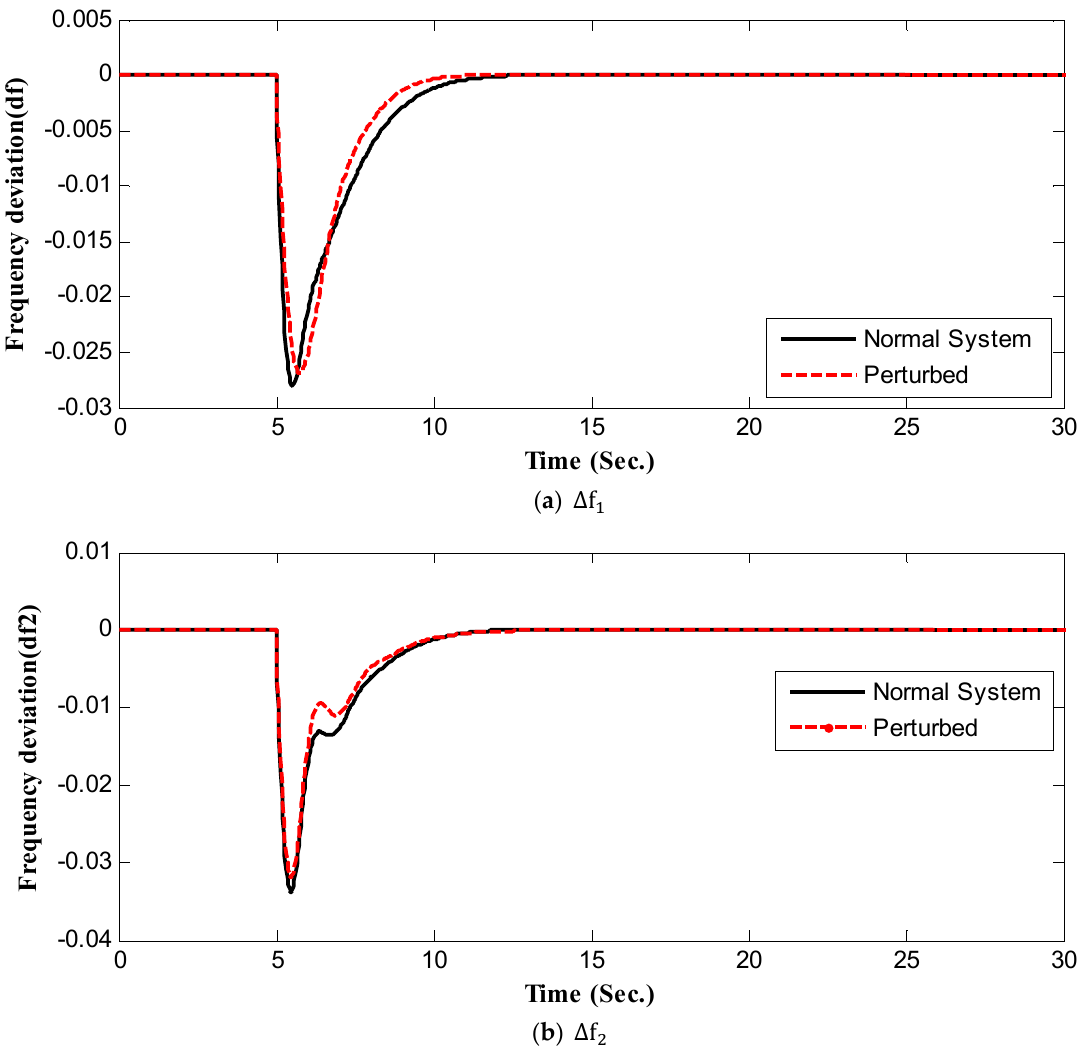
Figure 32. Dynamic response under normal and perturbed system using the proposed scheme.